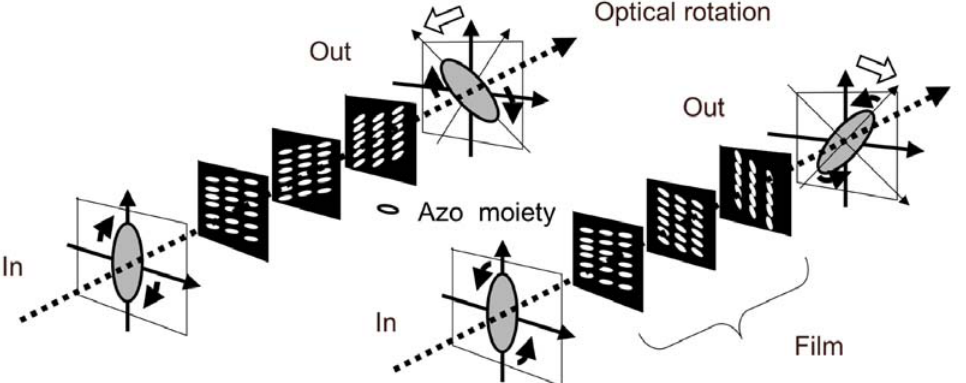
Figure 17. Schematic illustration of photoinduced supramolecular helical structure formation for ( a ) left-handed elliptically polarized and ( b ) right-handed elliptically polarized light,